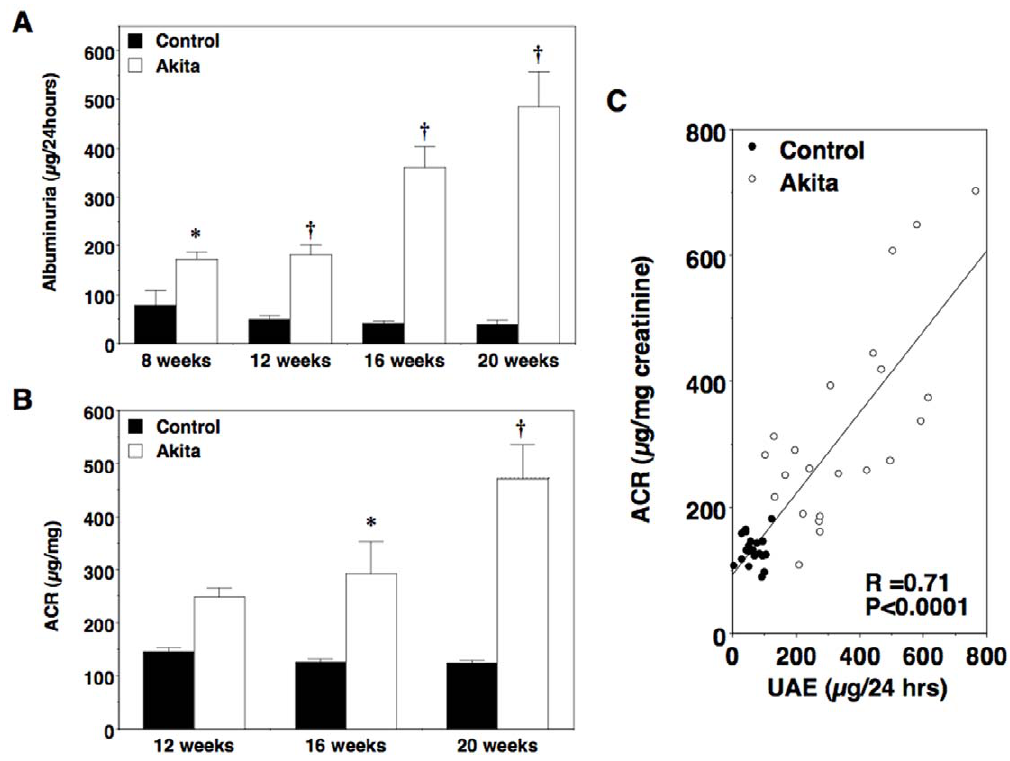
Figure 2. Urinary albumin excretion (UAE) in male Akita mice. (A) UAE was significantly elevated compared with controls in diabetic Akita mice by 8 weeks of age. By 20 weeks of age, there was a . 10-fold increase in albuminuria in diabetic mice compared to control animals. (B) Albumin- to-creatinine ratio (ACR) was also significantly increased in diabetic mice compared to age-matched controls. (C) There was a linear relationship between 24-hour UAE and ACR in all mice (R 2 =0.71; P , 0.0001). Black bars=control (n=6 to 8); white bars=Akita (n=6 to 8). Black circles=control; white circles=Akita. Data are mean 6 SEM. *P , 0.05 or { P , 0.0001 vs. age-matched controls.